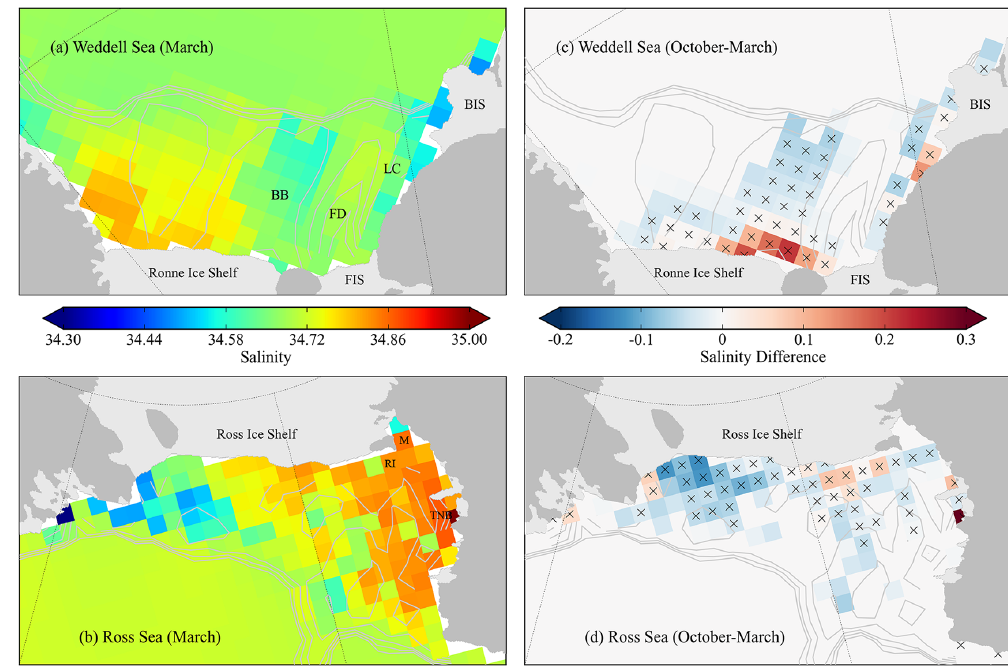
Fig. 9. Mean (1985–2011) modelled bottom salinity in summer (March) of the (a) Weddell and (b) Ross shelf seas, and the difference between the winter (October) and summer (March) bottom salinity of the (c) Weddell and (d) Ross shelf seas. The crosses highlight grid cells where the mean maximum mixed-layer depth is greater than 90% of the water column depth. BB: Berkner Bank, FD: Filchner Depression, FIS: Filchner Ice Shelf, RIS: Ronne Ice Shelf, BIS: Brunt Ice Shelf, LC: Luitpold Coast, RI: Ross Island, RIS: Ross Ice Shelf, M: McMurdo Sound, TNB: Terra Nova Bay. Note that the deep ocean grid is capped at a depth of 1000m, meaning that the water north of the shelf break reflects the WOA09 data at this depth. The grey lines are isobaths spaced at 200m intervals up to 1000m.